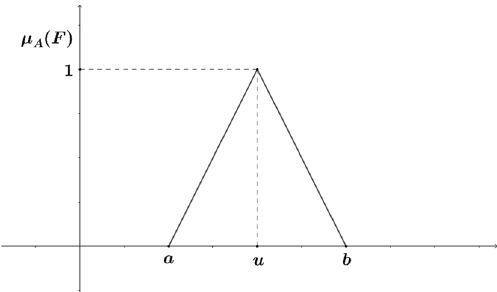
Fig. 1 Triangular fuzzy